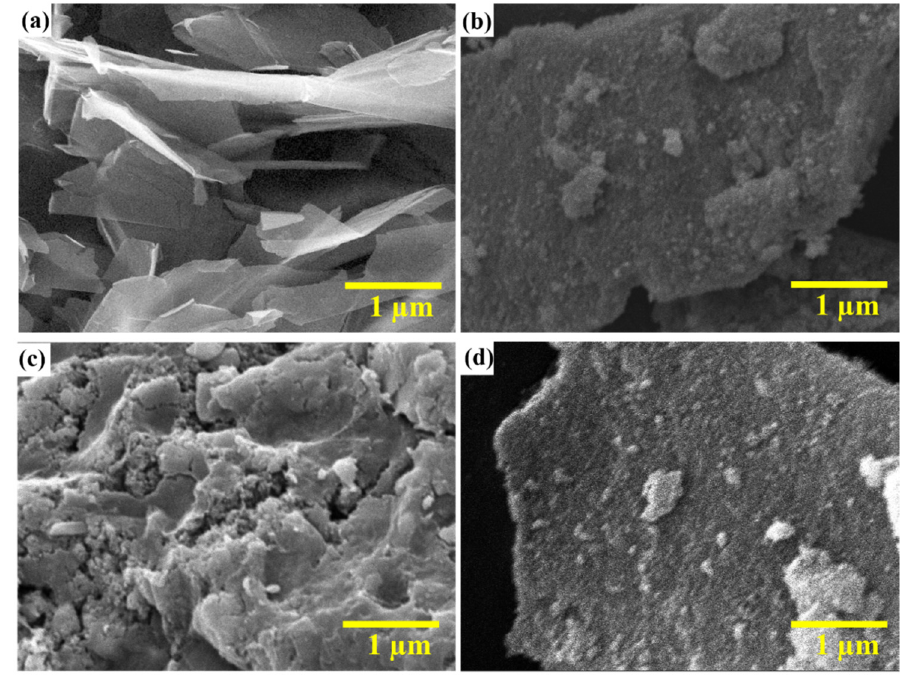
Figure 3. SEM image of ( a ) GO, ( b ) MGO, ( c ) NGO, and ( d ) NMGO .